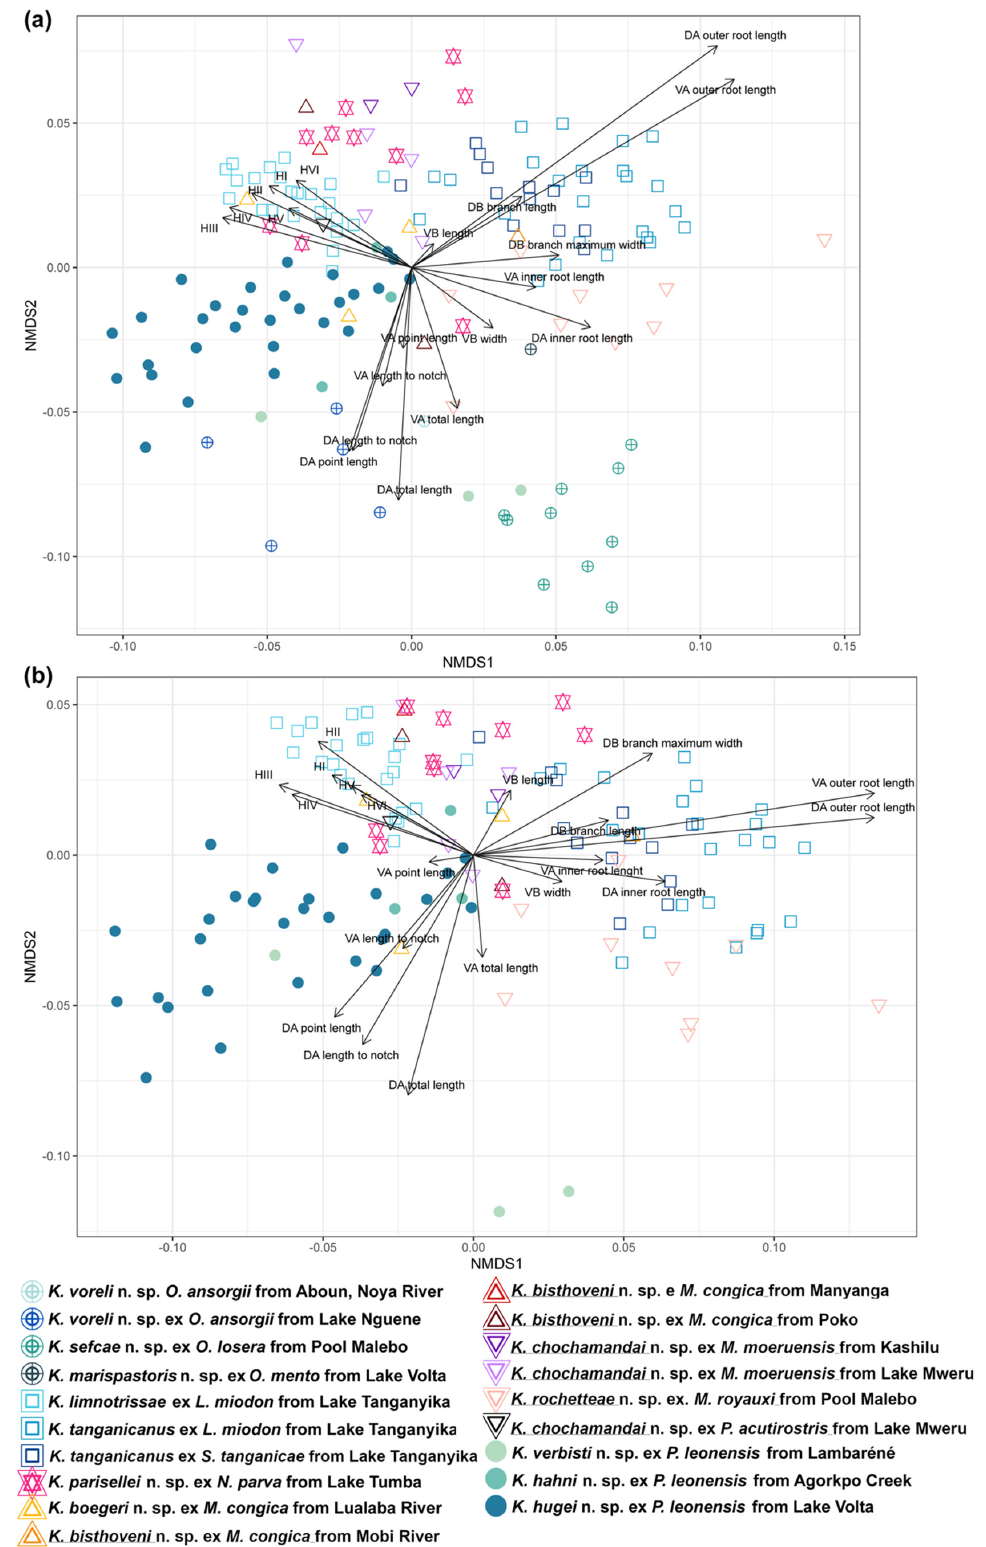
Figure 4. Morphometric variability of haptoral structures of Kapentagyrus spp. ( a ) Biplot of NMDS including all species of Kapentagyrus . ( b ) Biplot of NMDS excluding species infecting members of Odaxothrissa . Colours and signs denote parasite species, host species, and locality of origin.